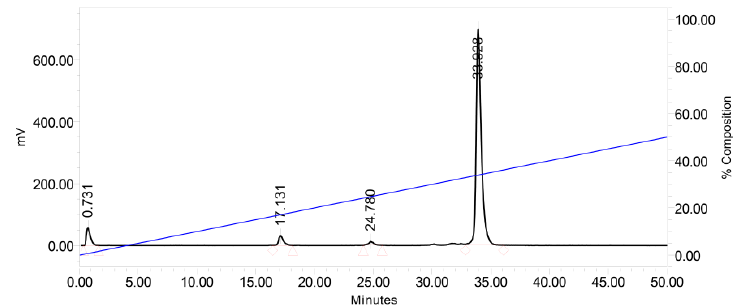
Figure 3. Radiochromatogram of HPLC analysis of mouse blood sample collected 30 min pi of [ 67 Ga]NeoBOMB1, showing the presence of 90% intact [ 67 Ga]NeoBOMB1 in peripheral mouse blood at t R = 33.9 min, as determined by co-injection of a [ 67 Ga]NeoBOMB1 sample in the HPLC.